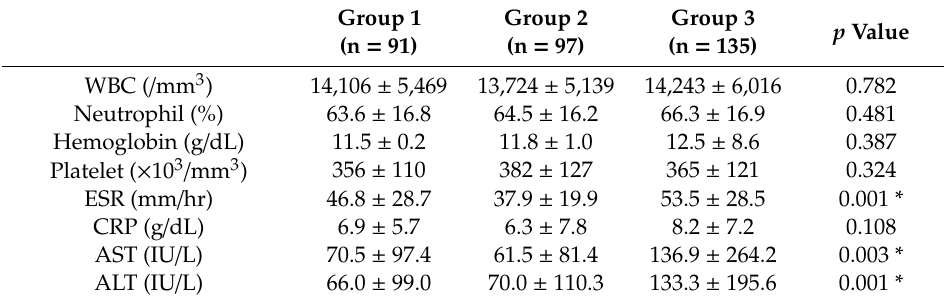
Table 2. Baseline laboratory data before intravenous immunoglobulin (IVIG) treatment.